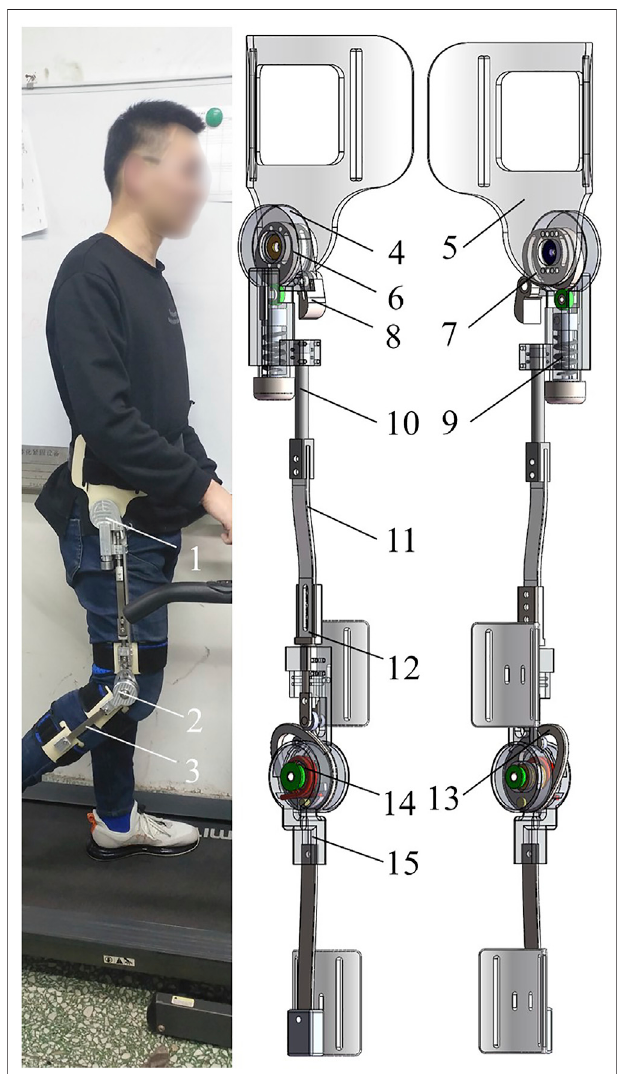
FIGURE 3 | (A) human-computer interaction of the exoskeleton. (B) Structural designofthe exoskeleton. 1-exoskeleton hip, 2-exoskeleton knee, 3- exoskeleton lower leg, 4-hip end cap, 5-waist connection plate, 6-hip master cam, 7-hip deputy cam, 8-pawl, 9-hip spring, 10-pushrod 3, 11-pushrod 2,12-pushrod1,13-kneecam,14-kneetorsionspring,and15-kneeoutercap.